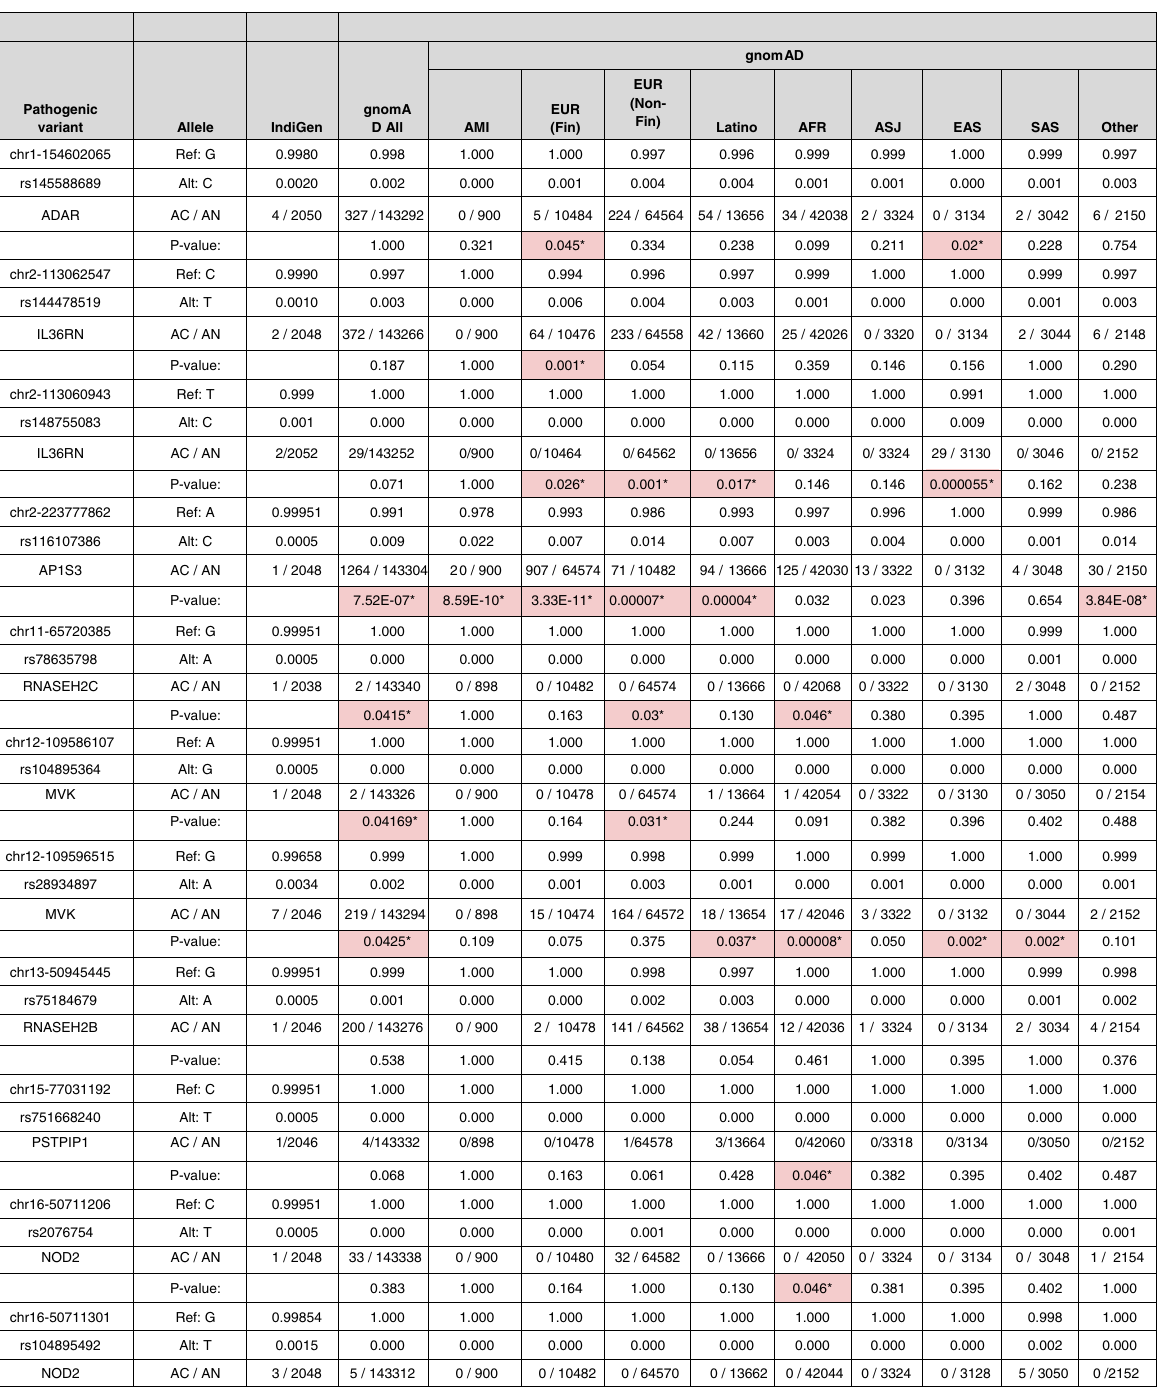
Table 3 IndiGen allele frequency comparison P value (< 0.05) of autoinflammatory disorder pathogenic and likely pathogenic variants with the gnomAD (global) database